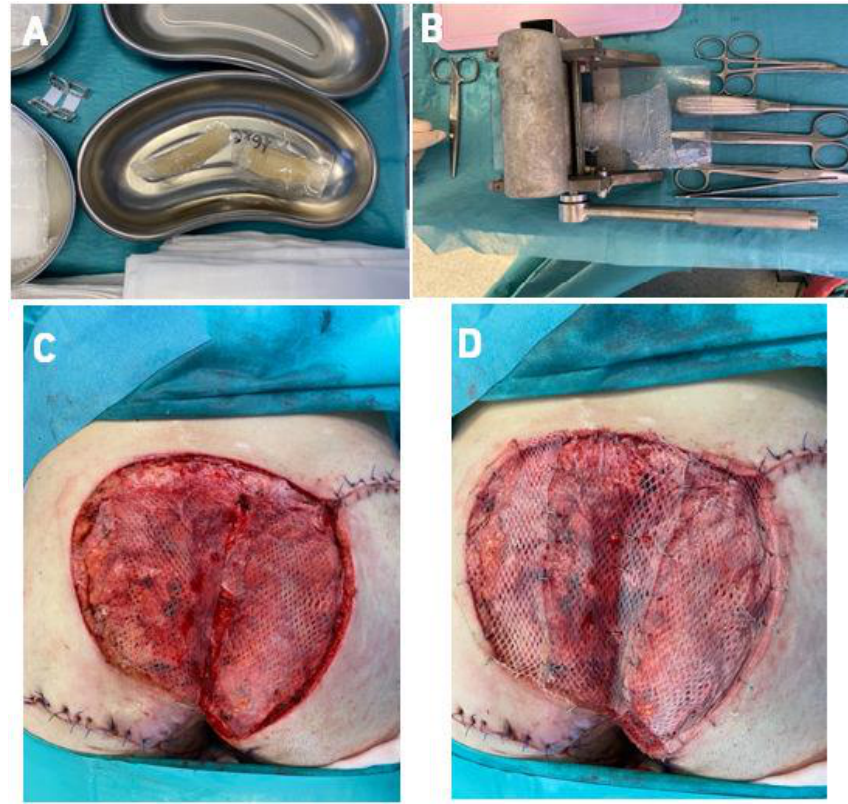
Figure 3. Stages of surgical procedure (case 1); ( A ) — Frozen ADM (defrosting procedure) before the operation, ( B ) — ADM meshing (ratio 1:1.5), ( C ) — application of ADM, ( D ) — STSG grafted onto ADM. Legend: ADM — Acellular Dermal Matrix, STSG — Split thickness skin graft.